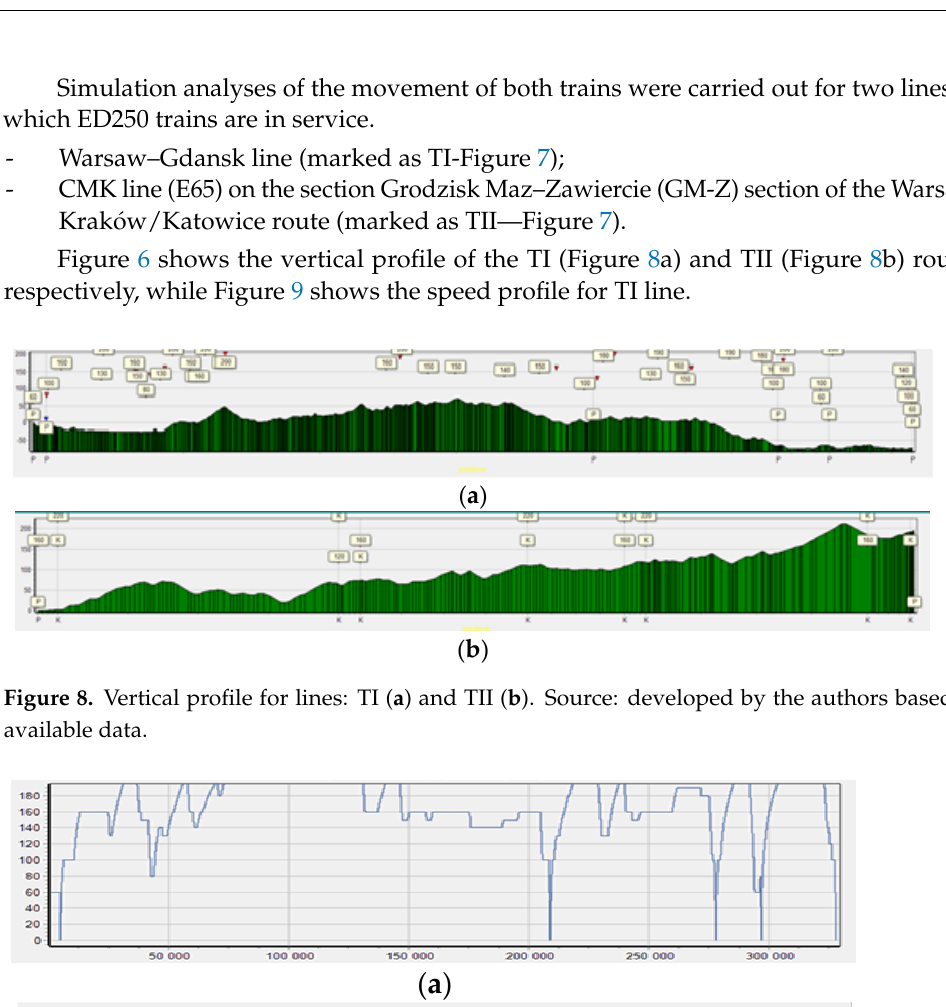
Figure 8. Vertical profile for lines: TI ( a ) and TII ( b ). Source: developed by the authors based on available data.